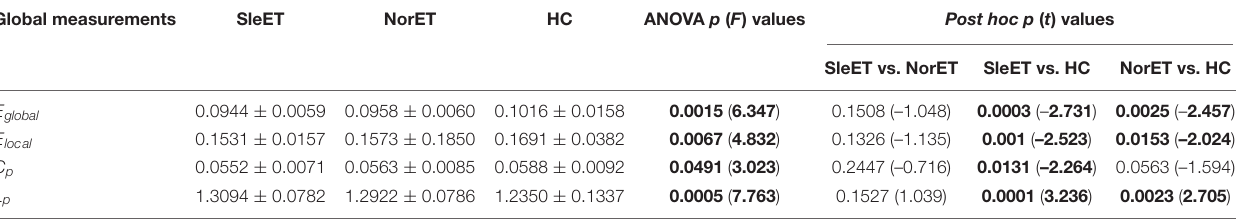
TABLE 2 | Global brain topological metrics showing differences between SleET and NorET patients and HCs. Global measurements